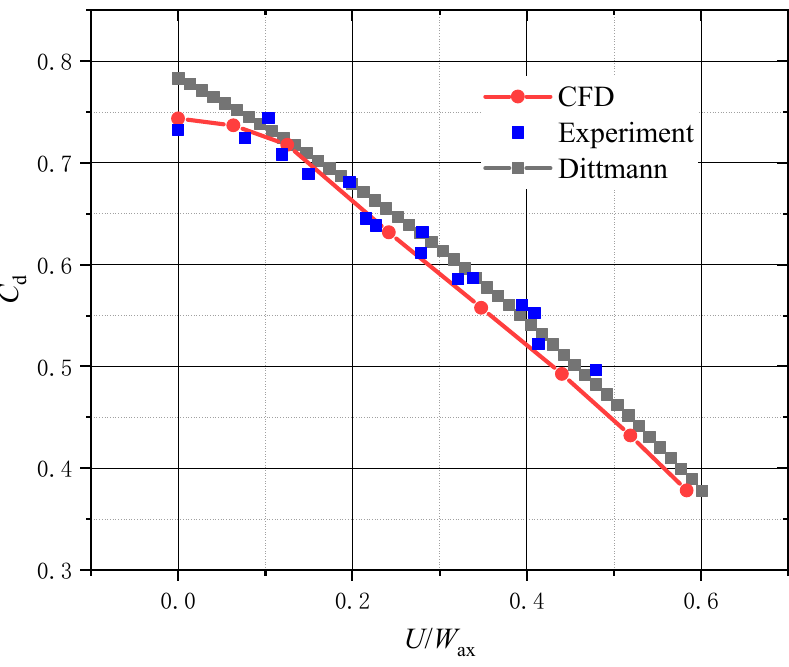
Figure 13. Comparison of CFD results and experimental data (present and reference [14]).